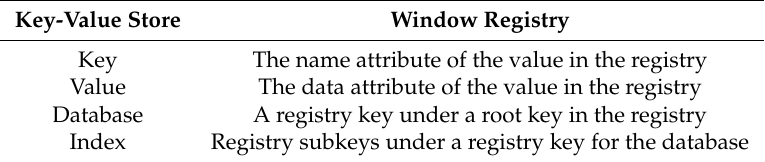
Mapping of the components in the key-value store onto the components in the Windows registry.